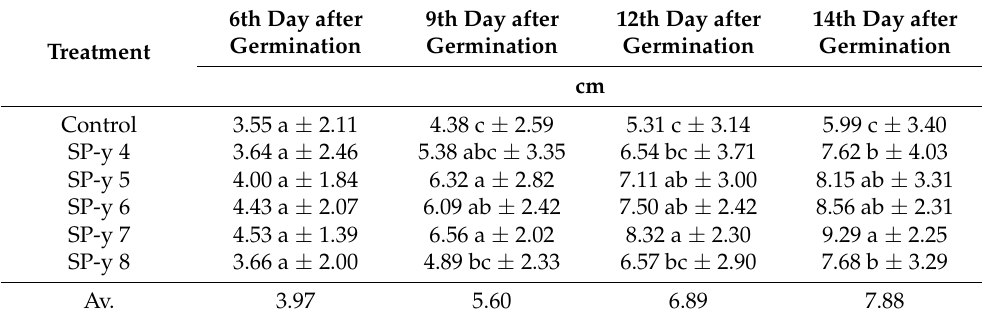
Table 3. Mean comparison of effects of six concentration levels of S. yanoikuyae SJTF8 on rice root lengths from 6 to 14 days after